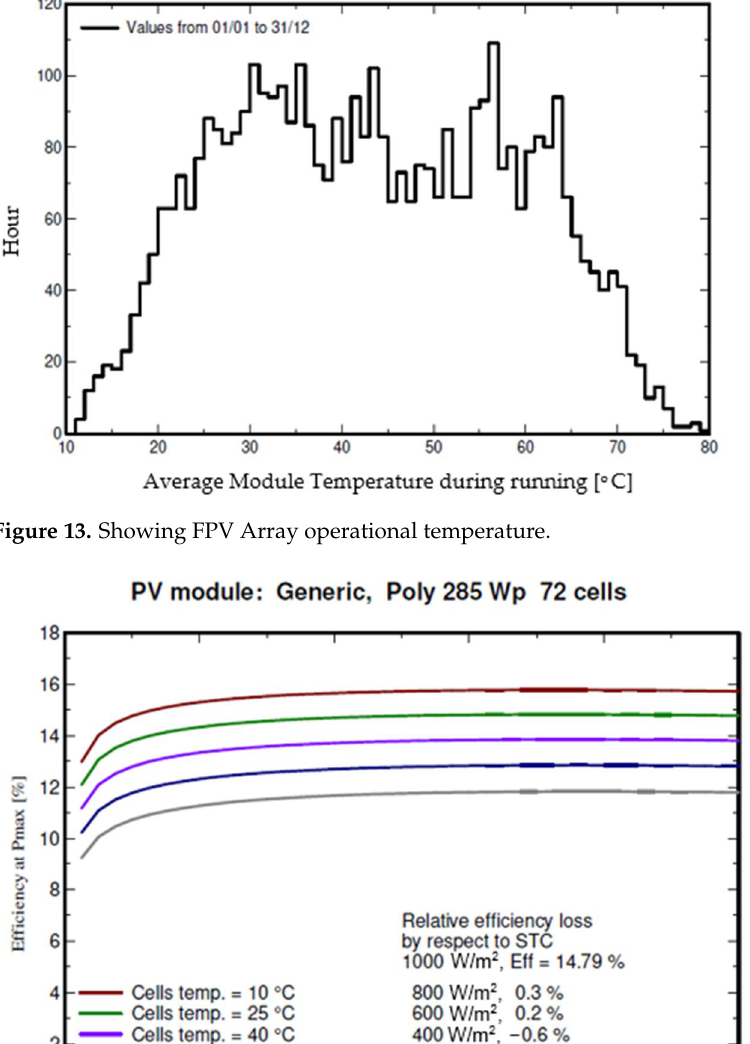
Figure 15. Figure showing FPV energy and efficiency vs. time (months). It must be mentioned that in the case of generation power being greater than that injected, as indicated in Equation (17), the excess can still be injected as the local and